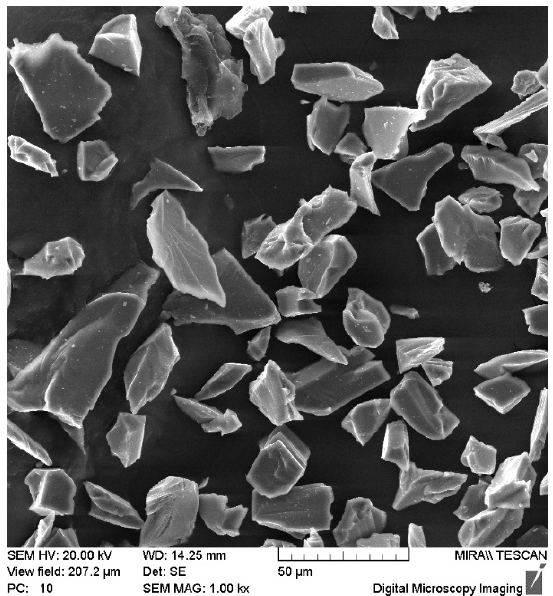
Figure 2. The SiC powder structure.